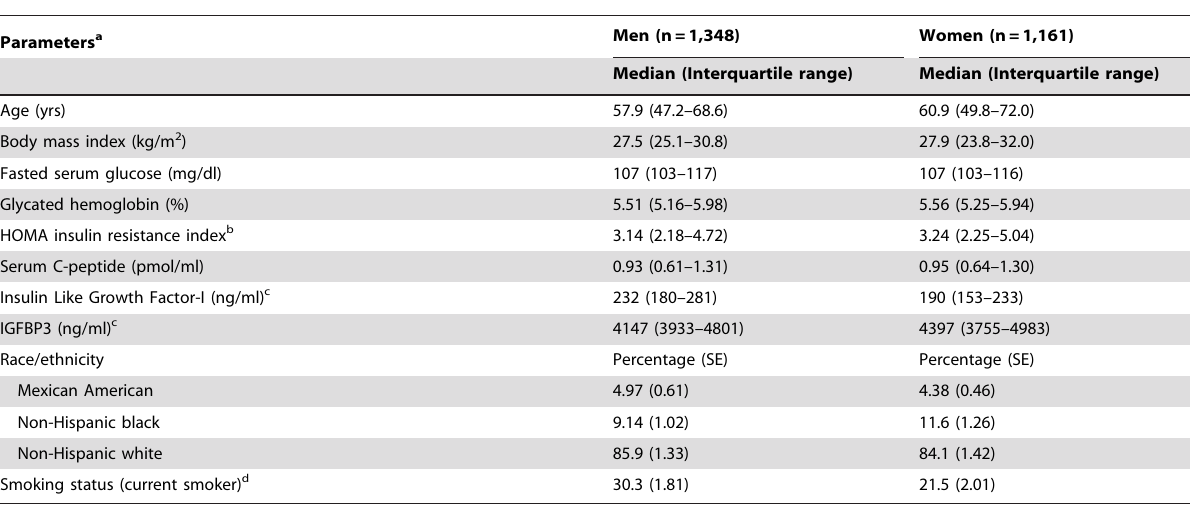
Table 1. Demographic characteristics of subjects – NHANES III, 1988–1994.